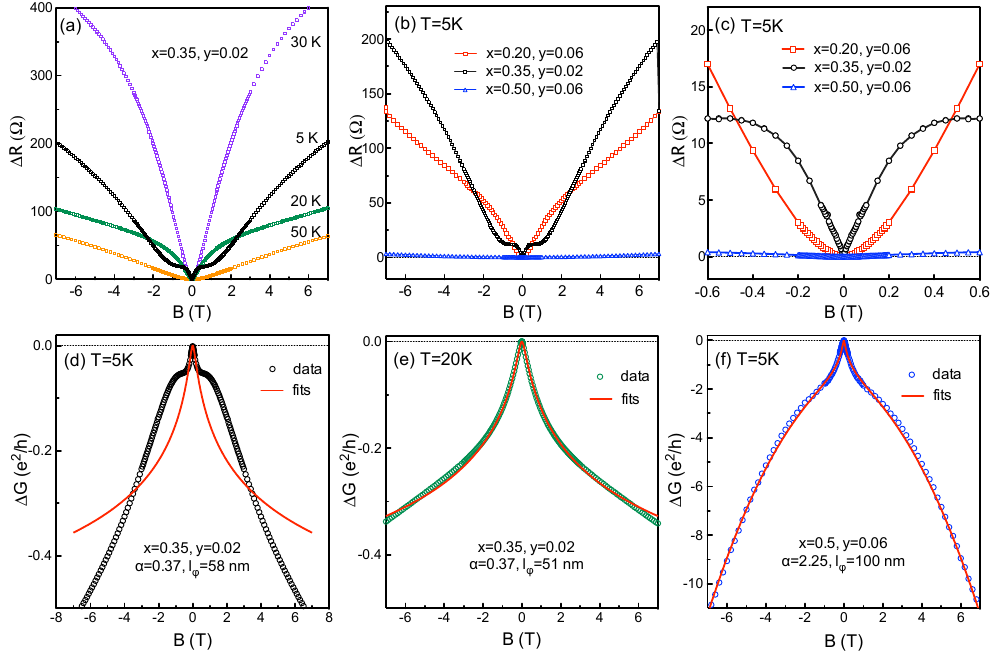
Figure 3. Weak antilocalization (WAL) magnetoresistance (MR) of (Pb 1 − x Sn x ) 1 − y In y Te. ( a ) MR for a (Pb 0.65 Sn 0.35 ) 0.98 In 0.02 Te sample measured at temperatures of T = 5, 20, 30, and 50 K in perpendicular magnetic fields of | B | ≤ 7 T. The WAL effect is overwhelmed at high temperatures by the bulk conduction states; ( b , c ) MR for (Pb 0.65 Sn 0.35 ) 0.98 In 0.02 Te (black), (Pb 0.5 Sn 0.5 ) 0.94 In 0.06 Te (blue), and (Pb 0.8 Sn 0.2 ) 0.94 In 0.06 Te (red) measured at 5 K in a full field range of ± 7 T and the enlarged low-field regime | B | ≤ 0.6 T; ( d , e ) Magnetoconductance ∆ G = ∆ ( 1/ R ) of the (Pb 0.65 Sn 0.35 ) 0.98 In 0.02 Te sample measured at 5 K and 20 K, respectively. Lines represent the result of fitting using WAL formula with fixed α = 0.37 and variable l φ = 51 nm (20 K) and 58 nm (5 K); ( f ) Magnetoconductance of the (Pb 0.5 Sn 0.5 ) 0.94 In 0.06 Te sample measured at 5 K. Line is fitted by the WAL formula together with an additional − B 2